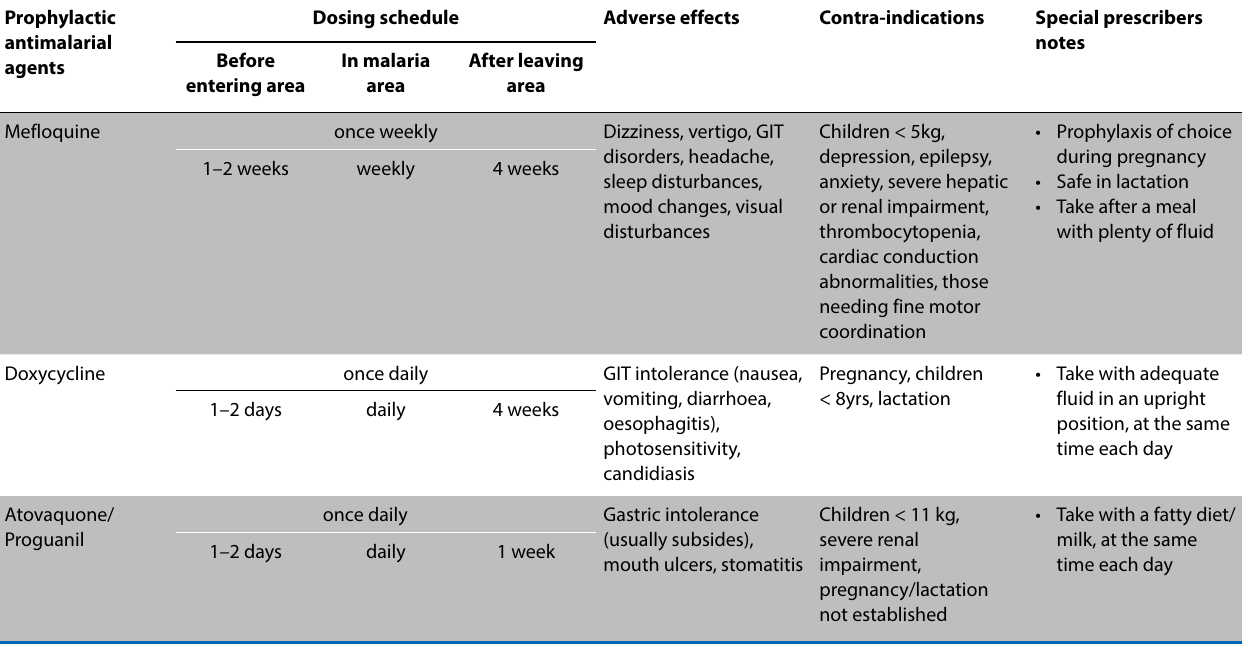
Table ll: Pharmacological profile of prophylactic drugs 1,4,8,9